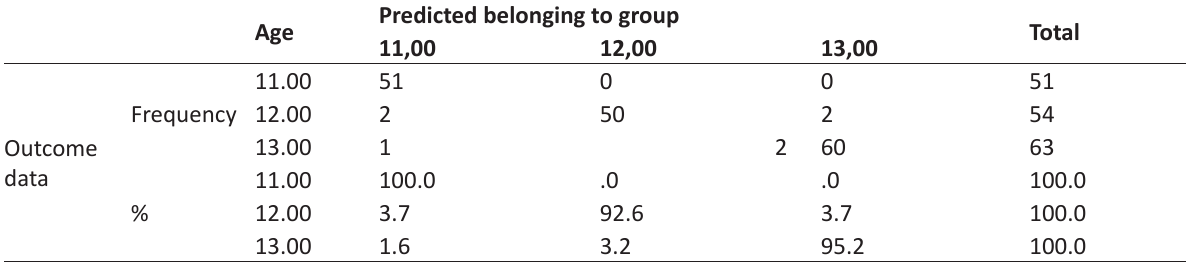
Table 4. Results of